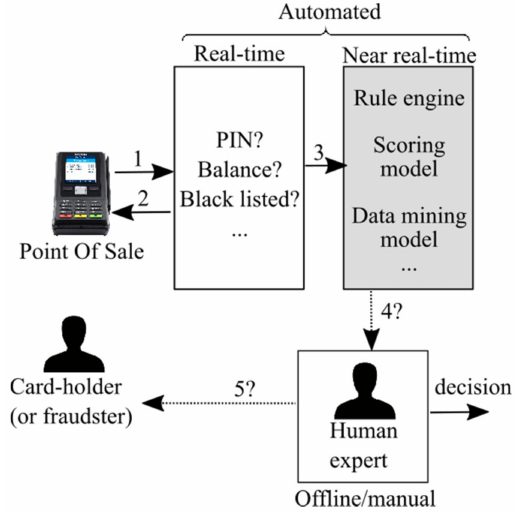
Figure 3. Simplified authorization and fraud detection flow